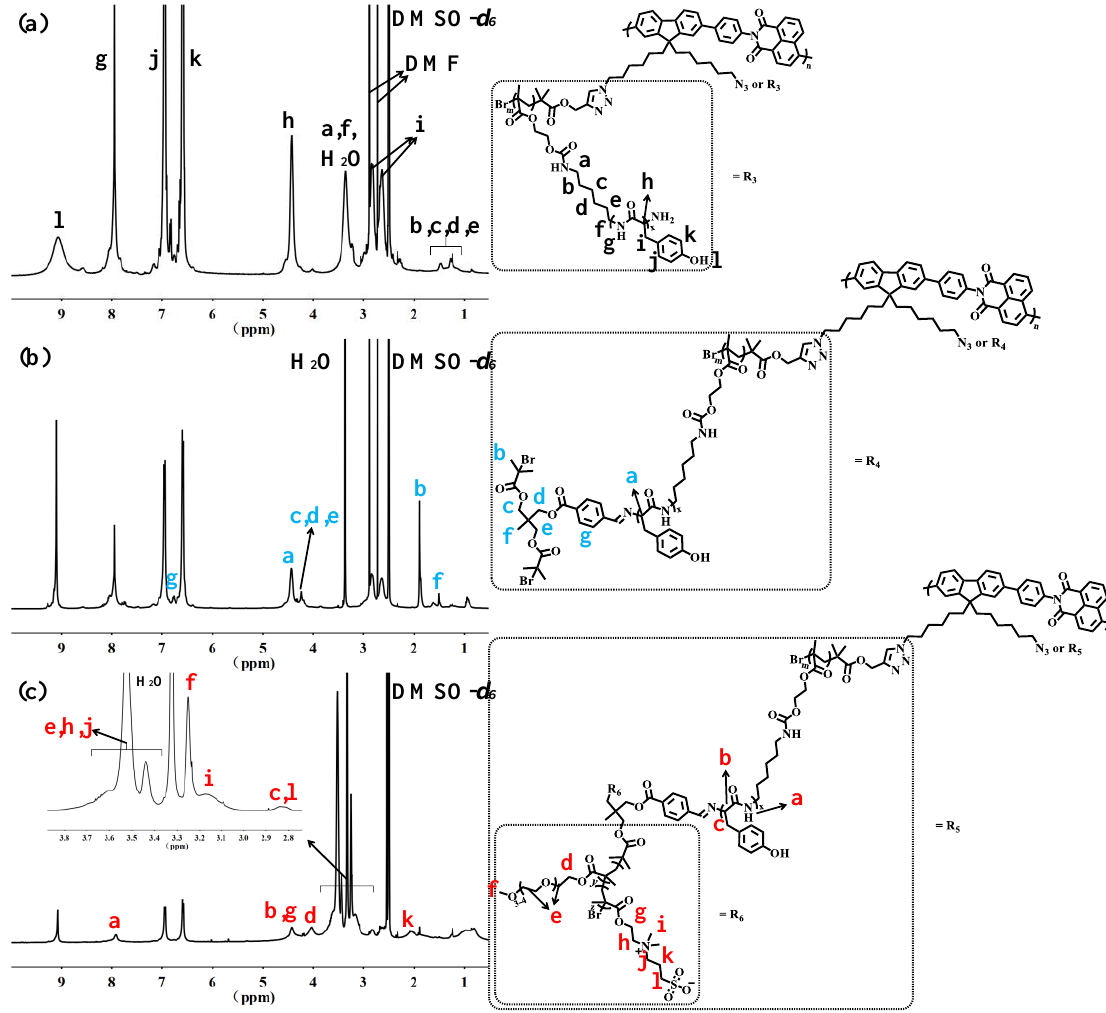
Figure 2. 1 H-NMR spectra of ( a ) PFONPN- g -(PHEMA- g -(PTyr-NH 2 )), ( b ) PFONPN- g -(PHEMA- g - (PTyr-Br 2 )), and ( c ) PFONPN- g -(PHEMA- g -(PTyr- b -P(OEGMA- co -SBMA) 2 )) in DMSO- d 6